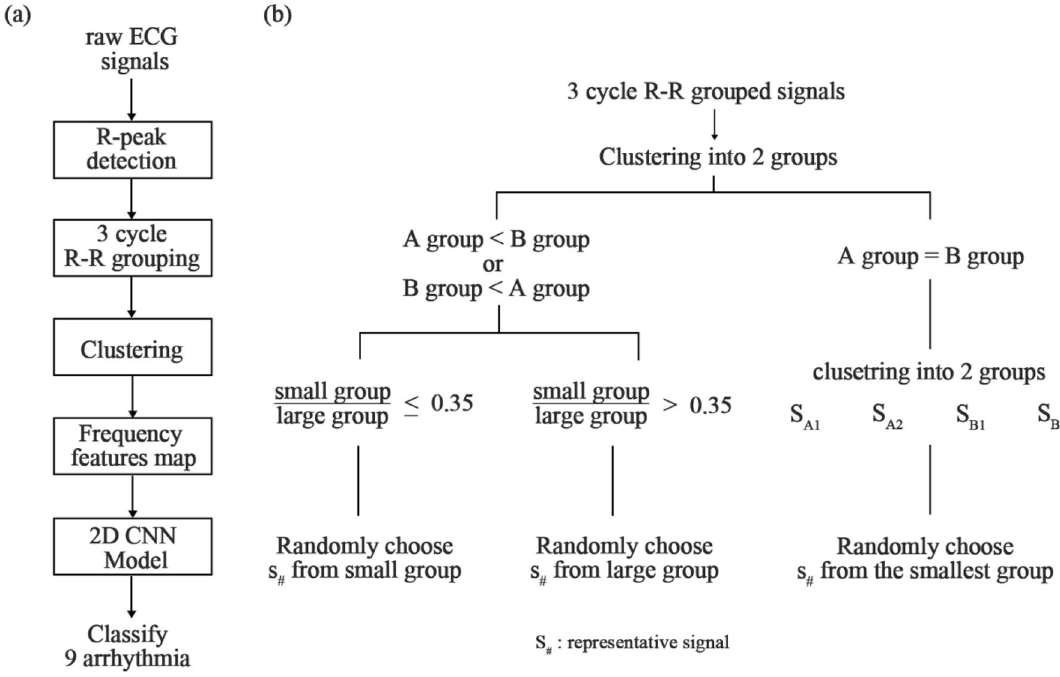
Figure 3. The workflow of the proposed model. ( a ) The workflow for the entire process; ( b ) the workflow for the clustering algorithm.